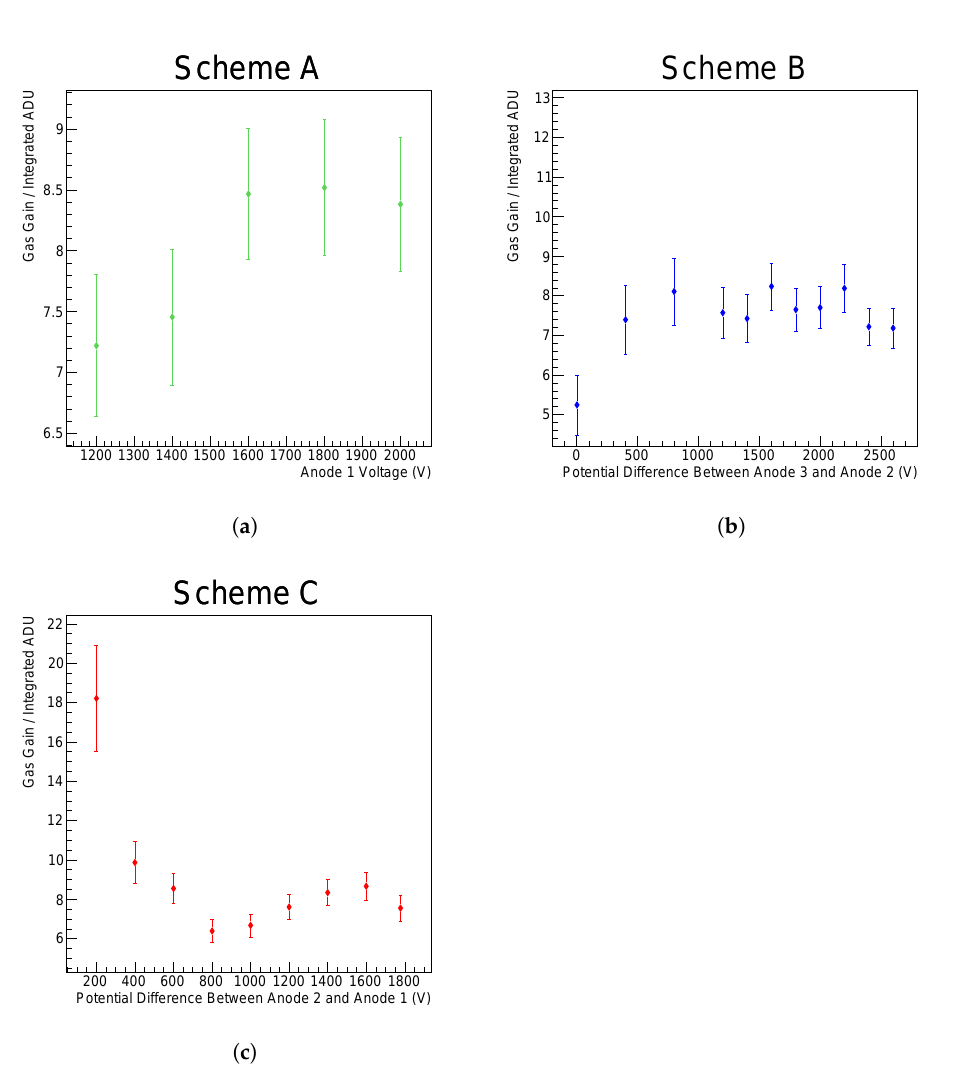
Figure 24. Ratio of gas gain measured in the amplification region at anode 3 (Figure 22, right column) to the measured intensity (integrated ADU) (Figure 15) vs. ( a ) anode 1 voltage ( V a 1 ), where the voltage differences between the meshes is always ∆ V a 12 = ∆ V a 23 = 1200V ( b ) potential difference between anode 2 and anode 3 ( V a 23 ), while the anode 1 and 2 voltages are kept constant ( c ) potential difference between anodes 1 and 2 ( ∆ V a 12 ), while V a 1 is kept constant and ∆ V a 23 is maintained at